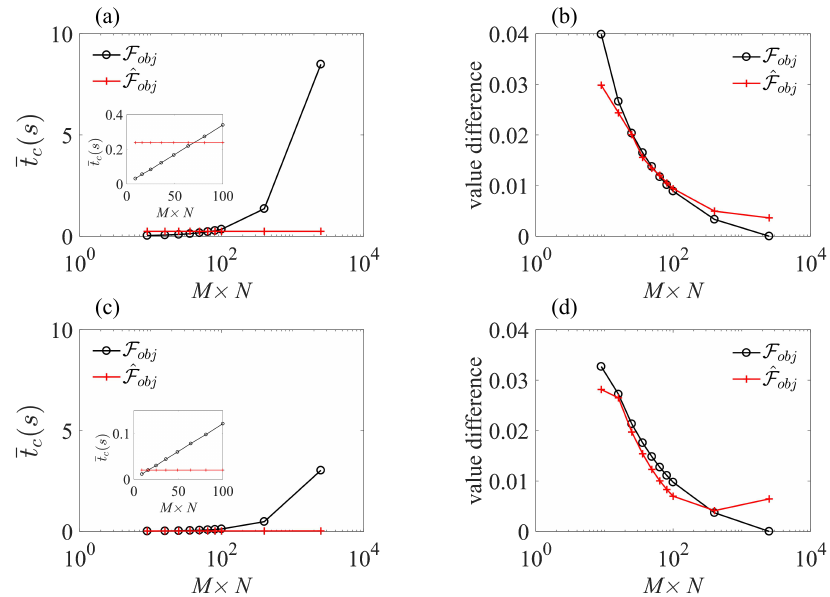
Figure 4. ( a ) Average computation time of the objective function as a function of calculating sample number M × N . In total, 100 processes under random control fields were calculated, and the estimation model parameter was updated in each process when computing ˆ F obj . Insert: Zoomed-in graph for M × N ≤ 100. ( b ) Average function value deviation as a function of calculating sample number M × N . Based on the same data as ( a ). The deviation was calculated by subtracting the values of f ( δ , κ ) , with M × N = 2500, i.e., |F obj − F obj ( M × N = 2500 ) | for the true value-based process and | ˆ F obj − F obj ( M × N = 2500 ) | for the predictor-based process. ( c ) Average computation time of the objective function as a function of calculating sample number M × N , where the estimation model parameter was fixed in all the 100 random processes. Insert: Zoomed-in graph for M × N ≤ 100. ( d ) Average function value deviation as a function of calculating sample number M × N . Based on (cid:104) (cid:105) ω 0 t + b the same data as ( c ). The control fields took the form of g ( t ) = a cos sin ( ν t ) , with evolution ν time T = 100 ns, and a , b and ν being randomly taken from ranges a ∈ [ 0,10 × 2 π ] MHz, b ∈ [ 0,2 π / T ] and ν ∈ [ 0,2 π / T ] . The sample number used in the estimation model was n =